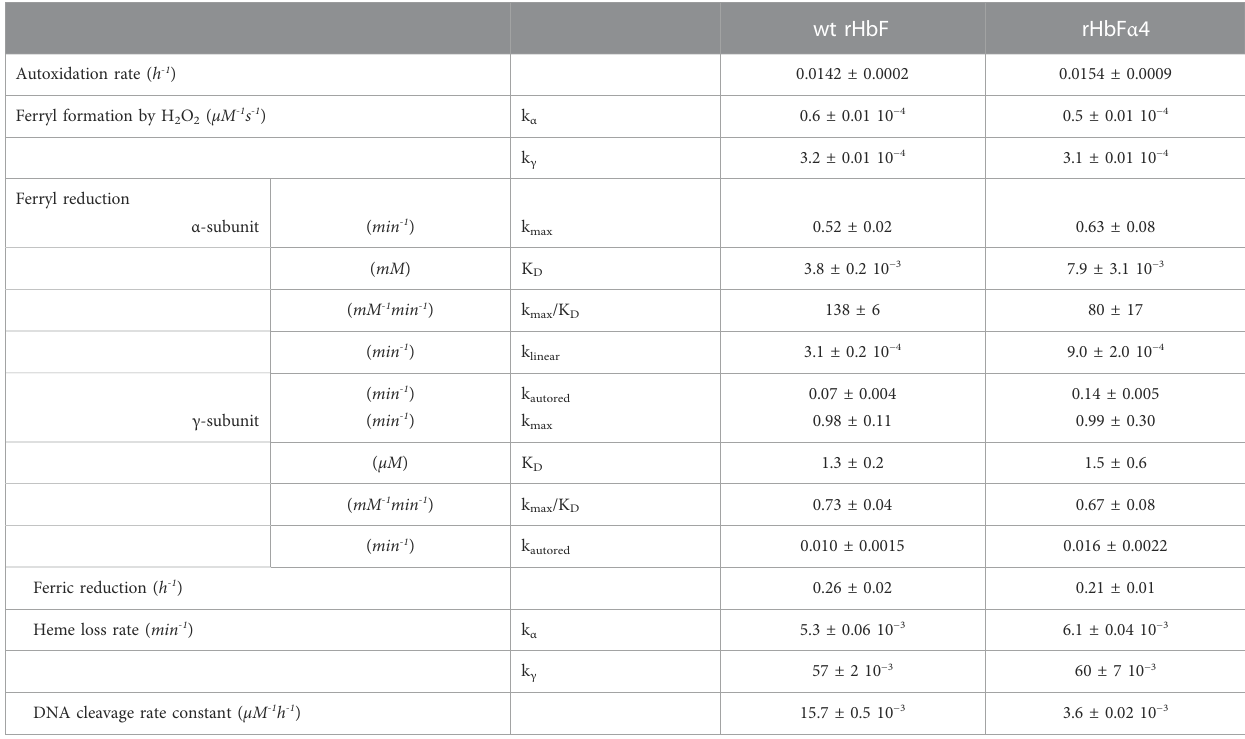
TABLE 1 Summary of the redox reaction rates, heme loss, and DNA cleavage of the wt rHbF and the rHbF α 4